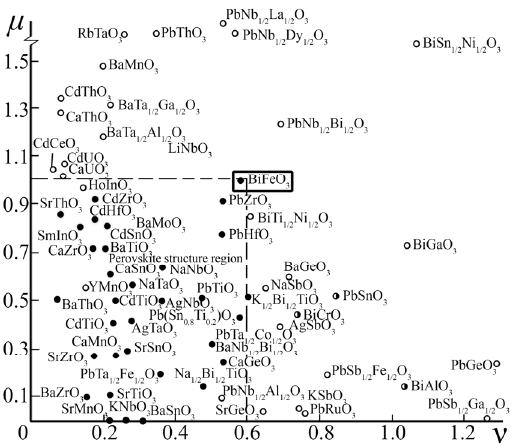
Figure 4. Diagram of directional parameters υ (characterizing the energy profitability of attaching atoms to each other along the directions of the highest concentration of electron density) and strength μ and the region of existence of oxides with a perovskite-type structure (OSP).